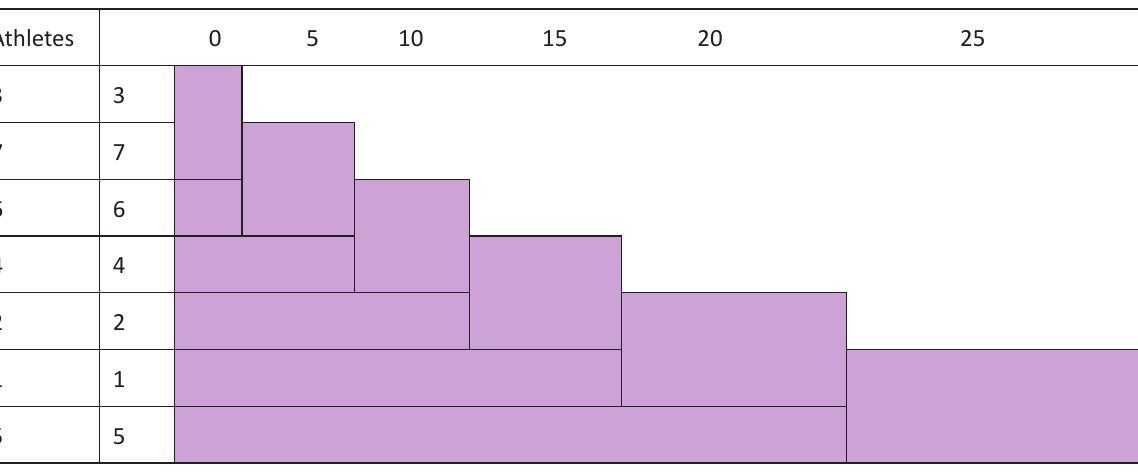
Fig. 4. Fragment of dendogram of athletes’ combining in